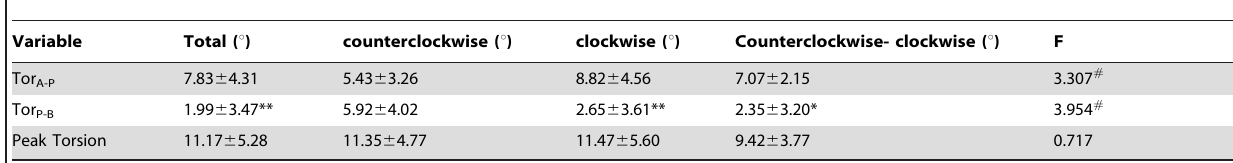
Table 3. Divide the LV into two parts at the papillary muscle short-axis levels, to compare their related parameters (mean 6 SD).